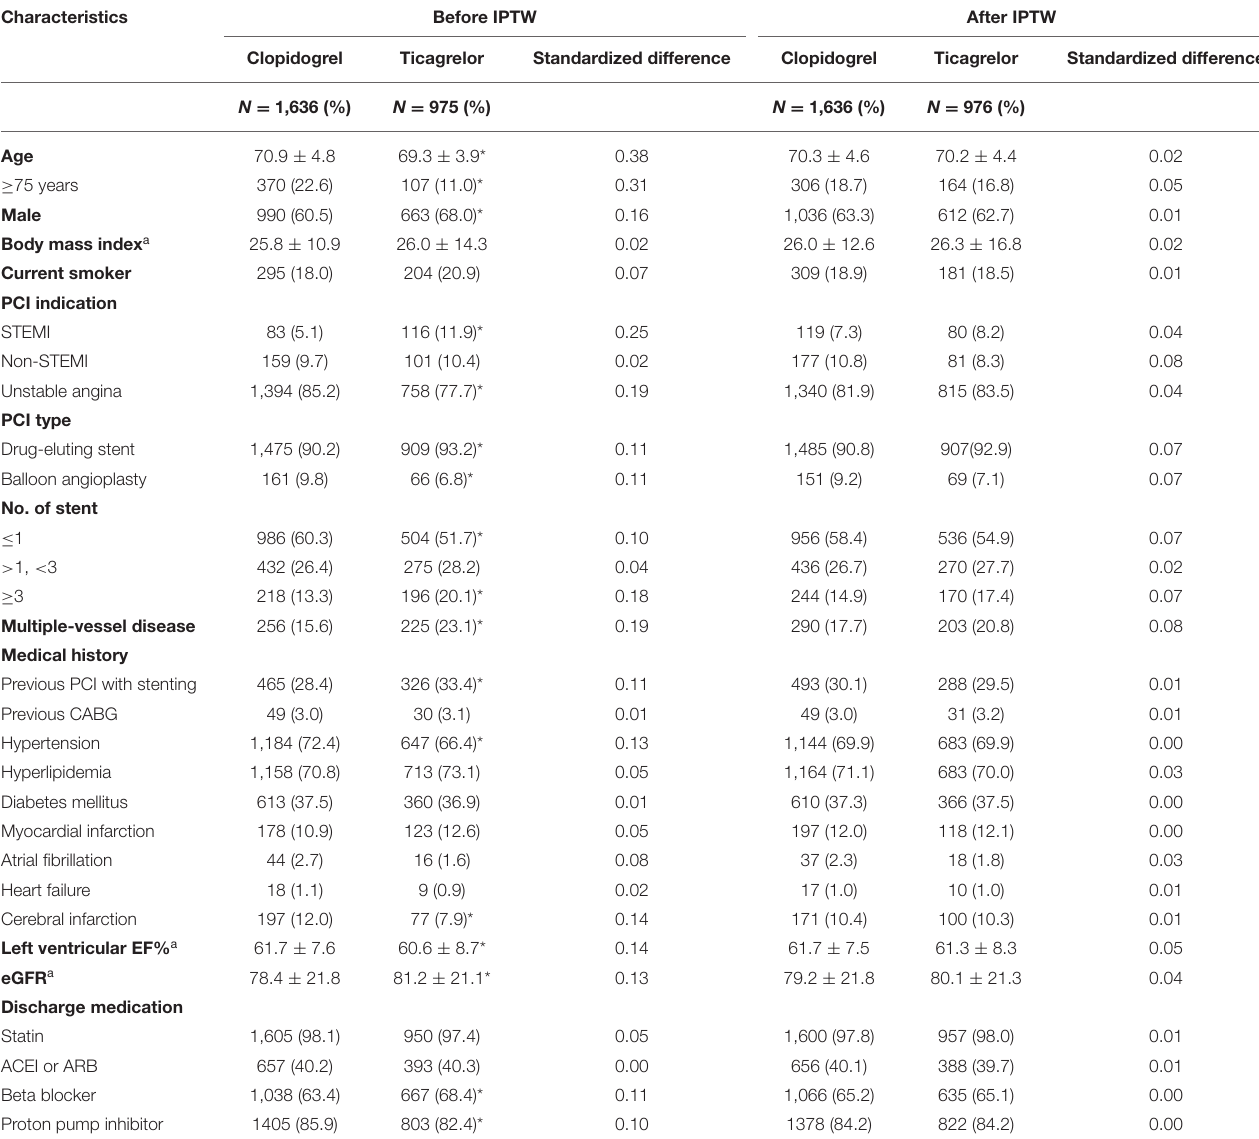
TABLE 1 | Patients’ demographic and clinical factors before and after IPTW.